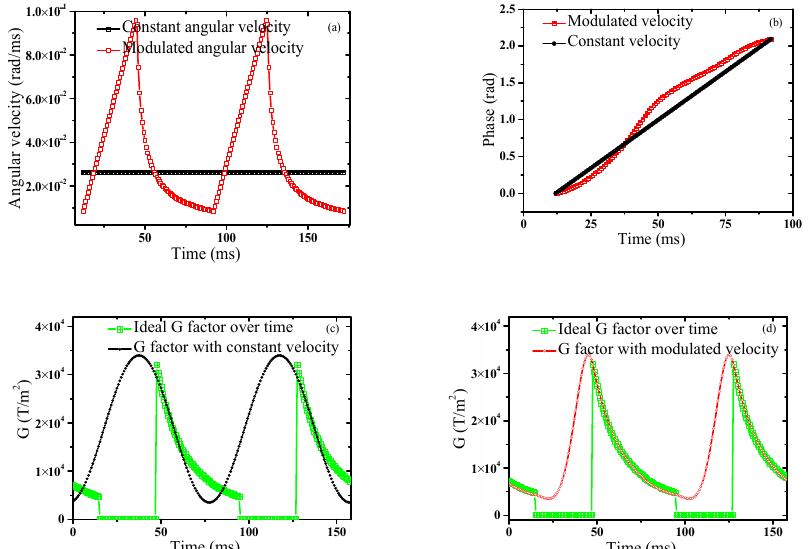
Figure 13. Angular velocity ( a ) and phases ( b ) of the outer sextupole with constant angular velocity (black curves) or modulated angular velocity (red curves); ( c ) G factor with the constant angular velocity in ( a ) compared with the ideal G factor, which can maintain a 5.5 m focal length over the wavelength band; ( d ) G factor with the modulated velocity in ( a ) compared with the ideal G factor.